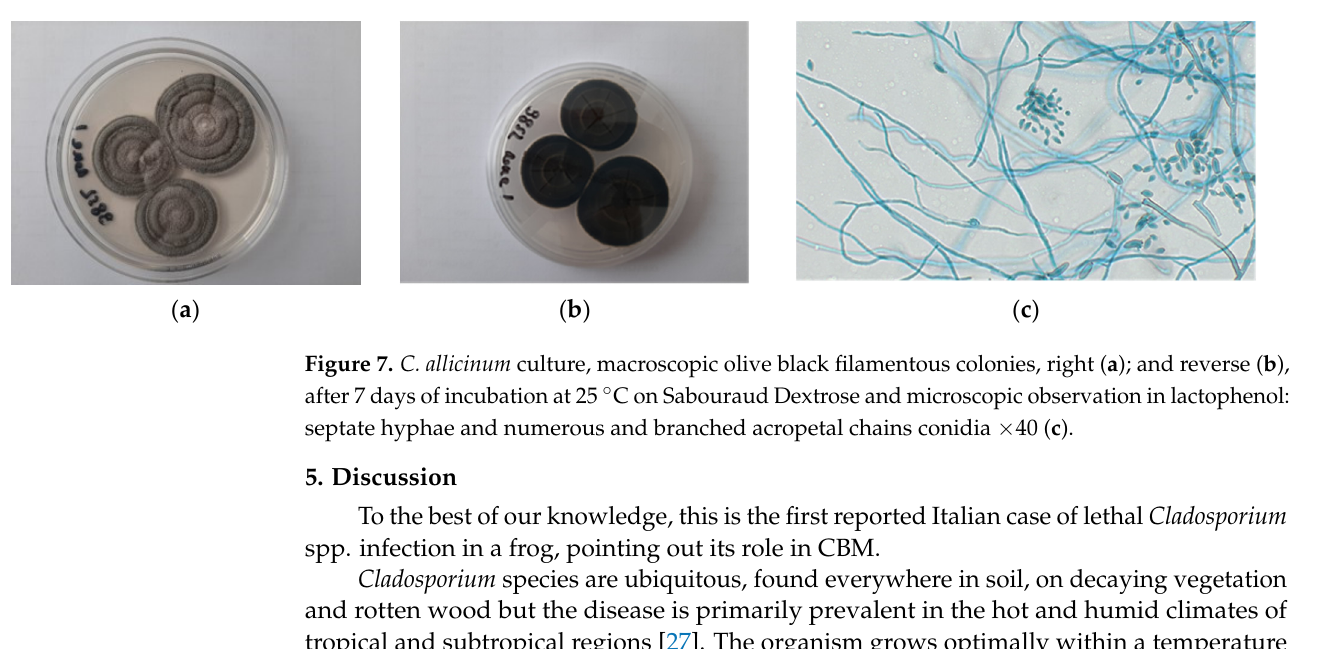
Figure 6. Nodular and diffuse granulomatous lesions in liver, kidneys, lungs and large intestine ( a ); and right lung, irregularly thickened, with grey-brownish lesions ( b ).